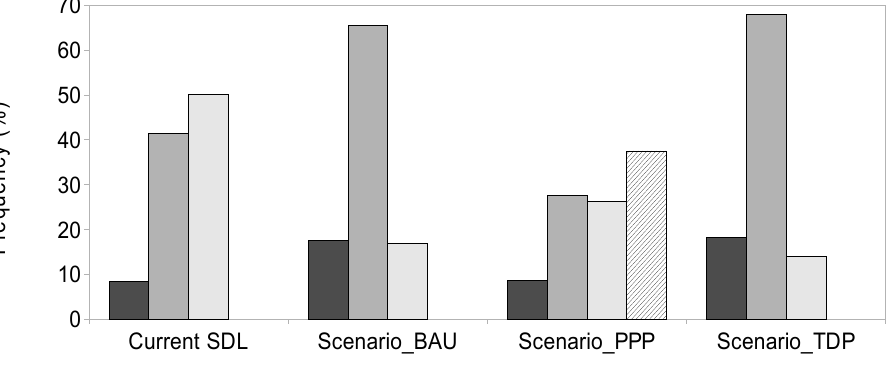
Figure 9. Simulated versus current SDL distribution frequencies according to the different scenario after 30